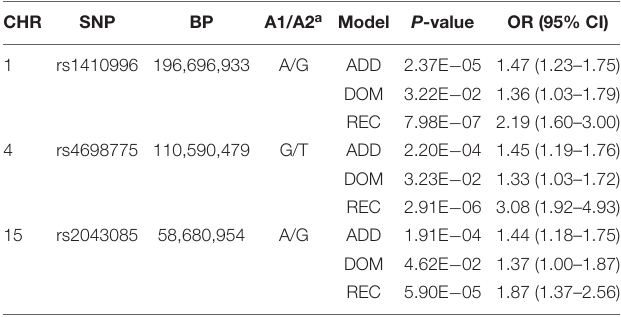
TABLE 2 | Association results for the three SNPs under three different models.